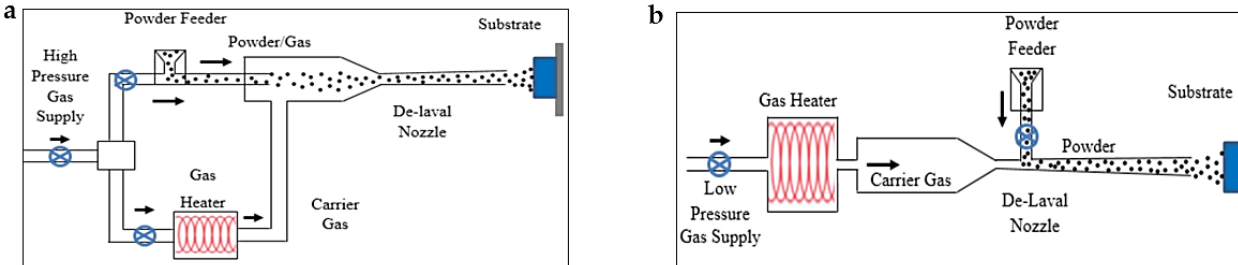
Figure 1. Schematic diagram of ( a ) HPCS and ( b ) LPCS [24]. Table 1. Spraying parameters of HPCS and LPCS.